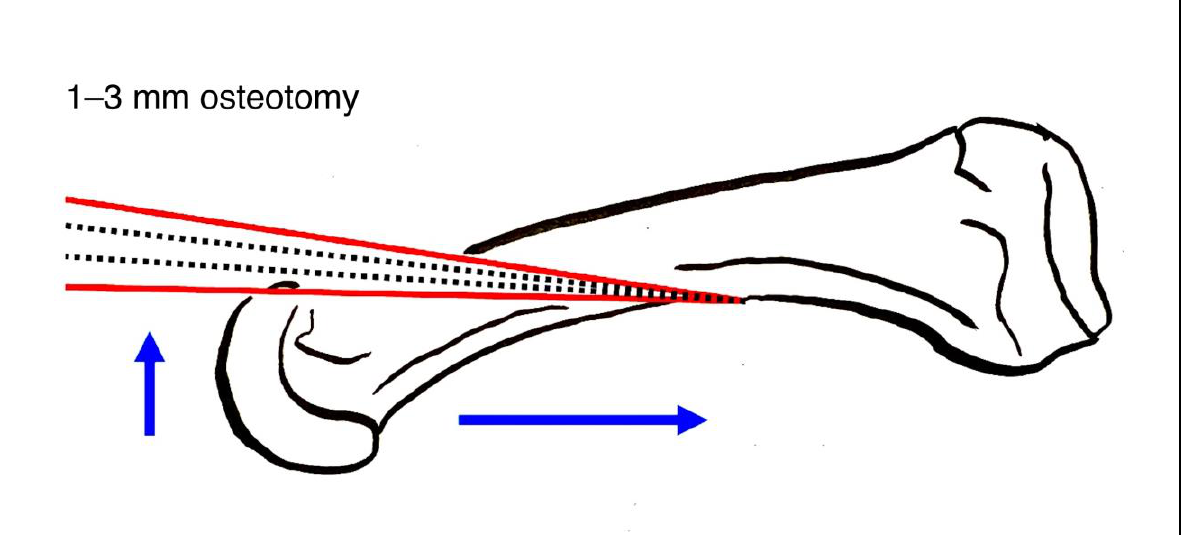
Figure 3. Weil osteotomy in wedge-cut technique.